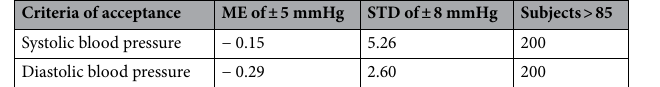
Table 3. Evaluation of the Concat_CNN approach based on AAMI standard.